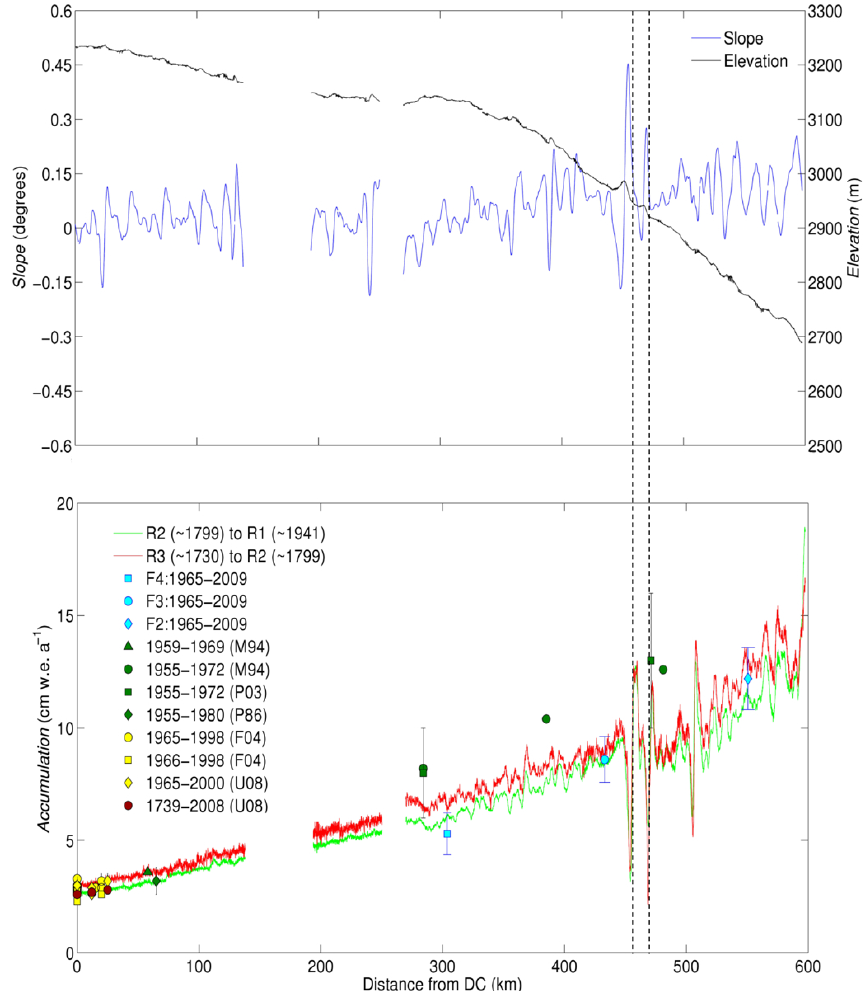
Fig. 8. Comparison of our accumulation results (radar and core measurements) and of previous studies along the transect. M94 = Mulvaney et al. (1994); P03 = Pourchet et al. (2003); P86 = Pettr´e et al. (1986); F04 = Frezzotti et al. (2004); U08 = Urbini et al. (2008). Upper panel shows elevation and